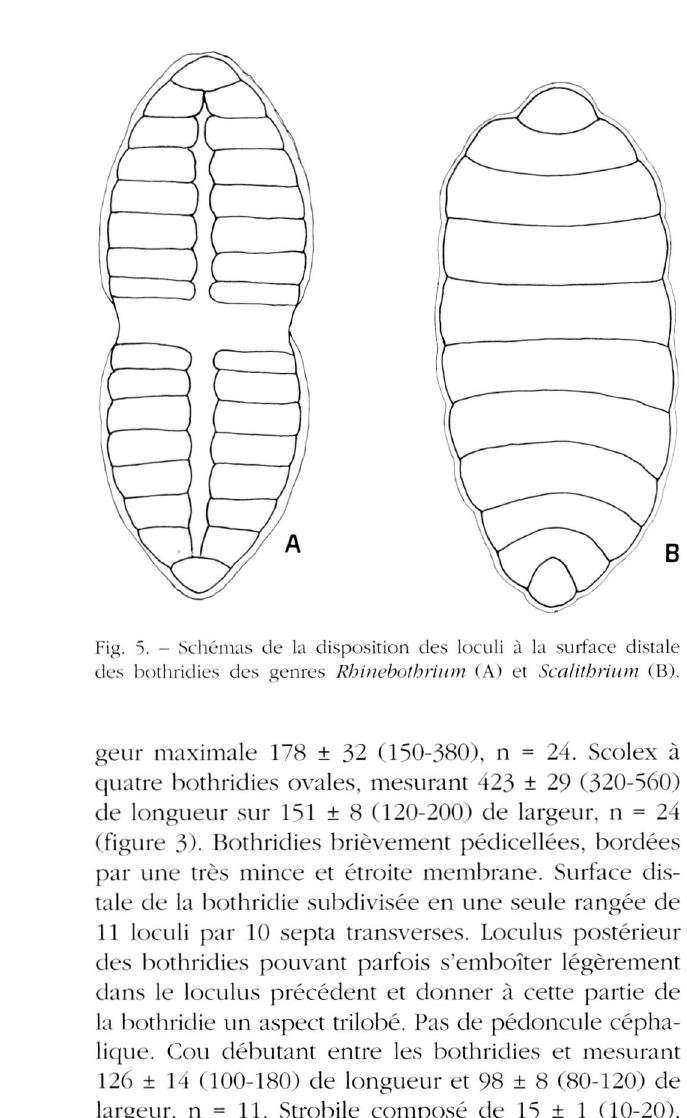
geur maximale 178 ± 32 (150-380), n = 24. Scolex